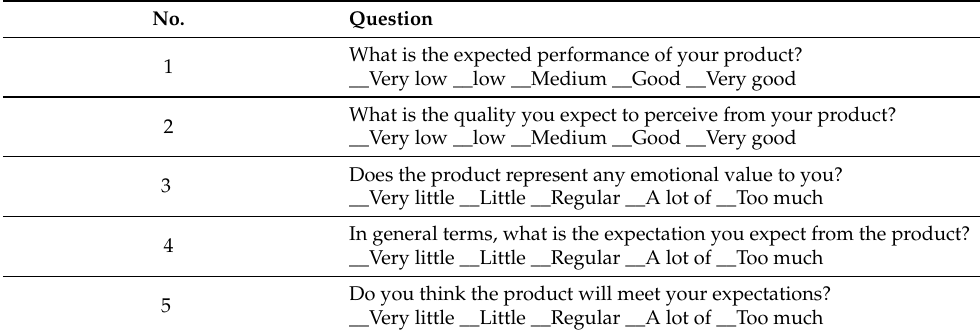
Table A5. Satisfaction questionnaire (satisfaction profile of the DM).